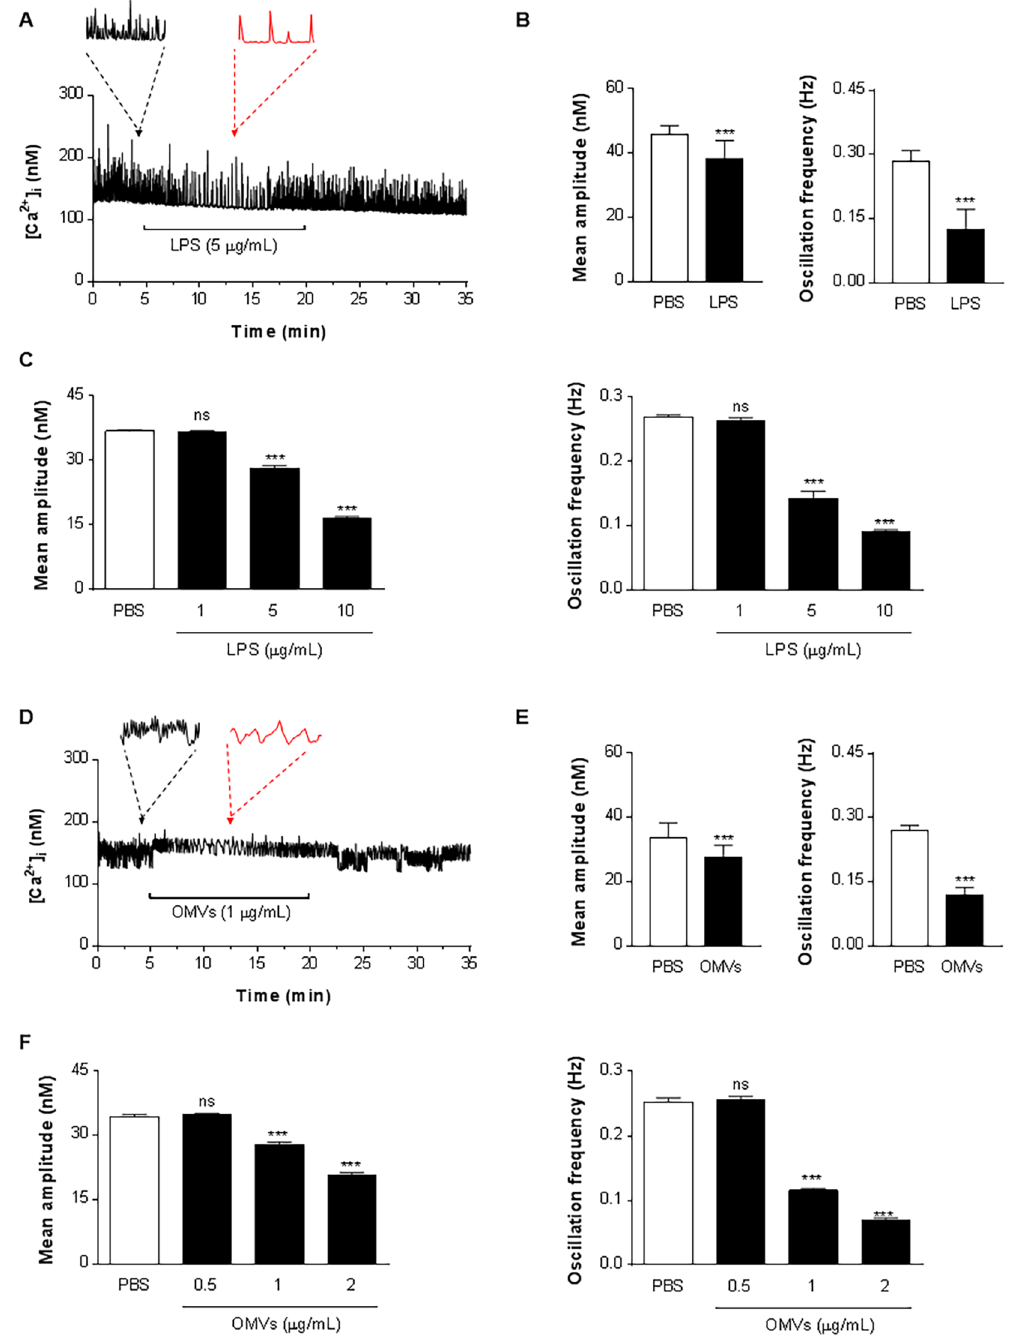
Figure 3. OMVs affect the change of intracellular calcium concentration in HL-1 cells. ( A and D ) LPS (5 µ g/ mL) ( A ) or OMVs (1 µ g/mL) ( D ) was applied for 15 min to the cells which were continuously perfused with the extracellular solution. Horizontal lines show application time of LPS or OMVs. Black and red arrows/dashed lines indicate the expanded traces acquired at a time point prior to (4 min) and following (14 min) infusion of LPS or OMVs. Traces show representative recordings from four separate experiments. ( B and E ) Mean amplitude and oscillation frequency of LPS- ( B ) and OMVs-treated cells ( E ) were quantified out of a total of 30 analyzed ROIs from four separate experiments in each group. ( C and F ) HL-1 cells were treated with LPS (1, 5, 10 µ g/mL) ( C ) or OMVs (0.5, 1, 2 µ g/mL) ( F ) for 15 min, and then mean amplitude and oscillation frequency were quantified out of a total of 30 analyzed ROI from four separate experiments in each group. ** * P < 0.001; ns, not significant; versus PBS group. Error bars indicate